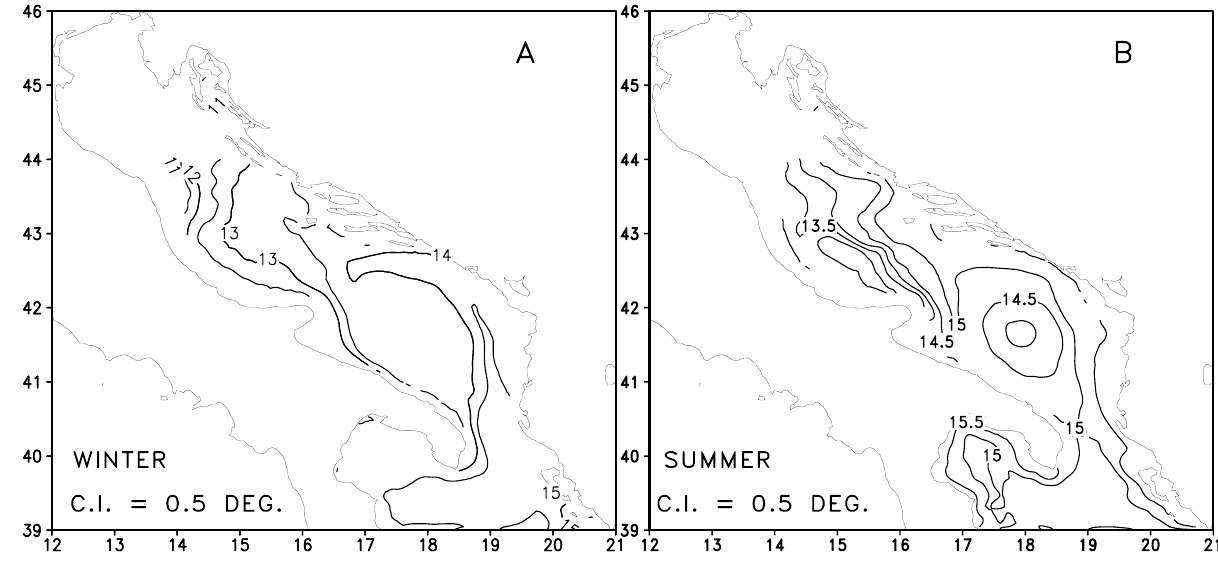
Fig. 9. Adriatic Intermediate Model (AIM). Seasonal temperature fields at 75m depth. (A) : winter, (B) : summer. Contour interval is 0.5 ◦ . Seasons definition as in Artegiani et al. (1997a, b).